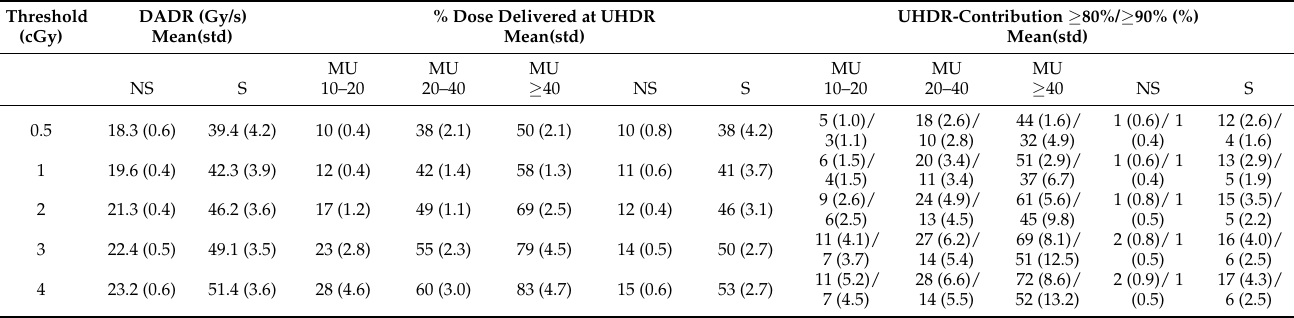
Figure 3. Dose within cross-section of a beam ( A ), with points with UHDR-contributions ≤10% (red) and ≥80% (green) for non-split ( B ) and split plan ( C ). Total dose threshold is 2 cGy. Table 2. Dose-rate results for multiple total dose thresholds. DADR = dose-averaged dose-rate, NS = non-split plan, S = split plan, MU = monitor unit. Data for the split plan will be influenced by the relative proportion dose delivered at different MU thresholds. All differences between non-split and split plans are significant, with p < 0.0001 (paired t-test, alpha = 0.05). All data are pooled and results are averaged for all beams from all